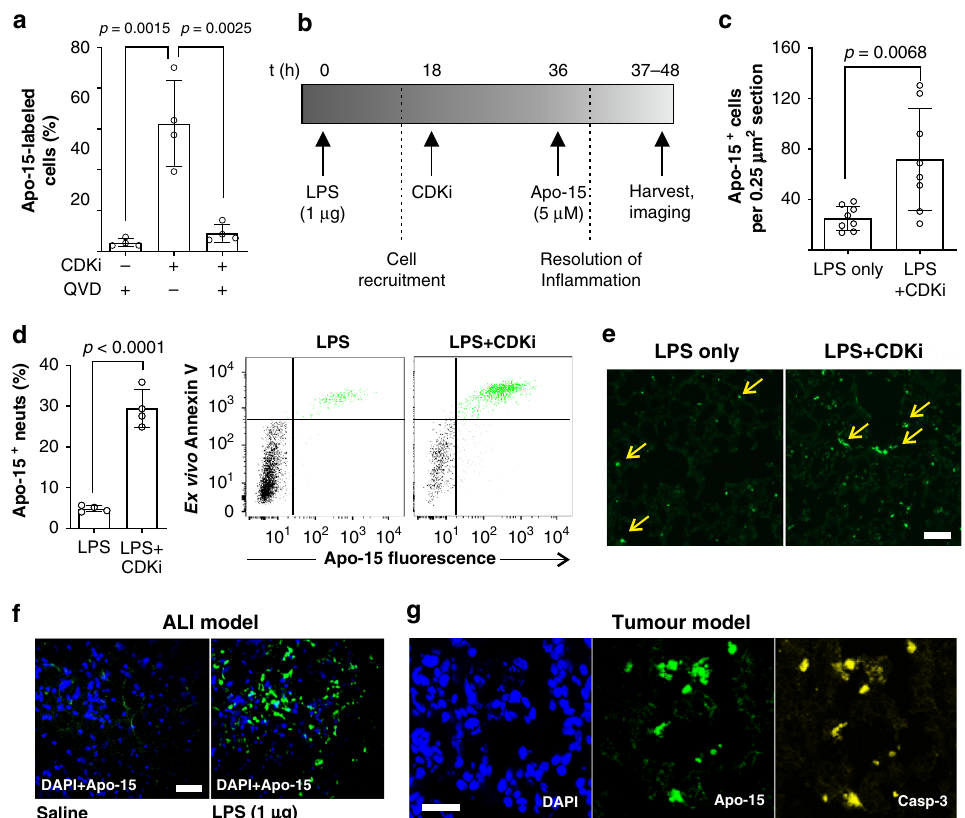
Fig. 5 In vivo administration of Apo-15 labels drug-induced apoptosis in different mouse models. a Human neutrophils were treated with R -roscovitine (20 µ M) in the absence or presence of QVD (10 μ M). Apo-15 -positive cells were determined by fl ow cytometry ( n = 4). b Experimental protocol for acute lung injury: LPS (20 μ g mL − 1 ) was instilled intratracheally and mice received CDKi (30 mg kg − 1 ) or saline intraperitoneally 18 h later. Apo-15 was administered intratracheally at 36 h. c Double-blind quanti fi cation of Apo-15 -positive cells in lung tissue from mice that received LPS or LPS and CDKi ( n = 8 per group). d Flow cytometric analysis of BALF from mice that received LPS (20 μ g mL − 1 ) or LPS (20 μ g mL − 1 ) and CDKi (AT7519, 4 mg mL − 1 ). Both groups were administered Apo-15 (5 μ M) in vivo and incubated with AF647-Annexin V (25 nM) ex vivo. Data presented as mean percentages ± s.d. of Apo-15 -positive CD45 + LY6G + apoptotic neutrophils ( n = 4). Representative dot plots of CD45 + LY6G + neutrophils with Apo-15 positive cells highlighted in green and Apo-15 -negative cells in black. Gating strategy in Supplementary Fig. 15B. e Fluorescence microscope images of sections of lung tissues from mice that received LPS or LPS and CDKi. Yellow arrows identify Apo-15 -positive events (green) from images with n = 8 per group. Scale bar: 100 µ m. f Low-magni fi cation intravital images of lungs of saline-treated and LPS-treated mice (LPS: 20 μ g mL − 1 ). Apo-15 was administered in vivo (5 μ M, green) and nuclei were counterstained with DAPI (18 μ M, blue) ( λ exc. : 405, 488 nm; λ em. : 450, 525 nm). Representative pictures from n = 3 per group. Scale bar: 50 μ m. g High-magni fi cation fl uorescence images (from three independent experiments) of tumors from xenograft breast cancer mouse models after treatment with cisplatin (10 μ g g − 1 ). Apo-15 was administered i.v. (5 μ M, green) and nuclei were counterstained with DAPI (10 μ M, blue) ( λ exc. : 405, 488 nm; λ em. : 450, 525 nm). Apoptotic cells were stained with anti-active caspase-3 (300 ng mL − 1 , yellow). Scale bar: 50 μ m. For ( a ), ( c ), and ( d ), p values were obtained from two-tailed t tests. Source data (in a , c , and d ) provided as a Source data fi